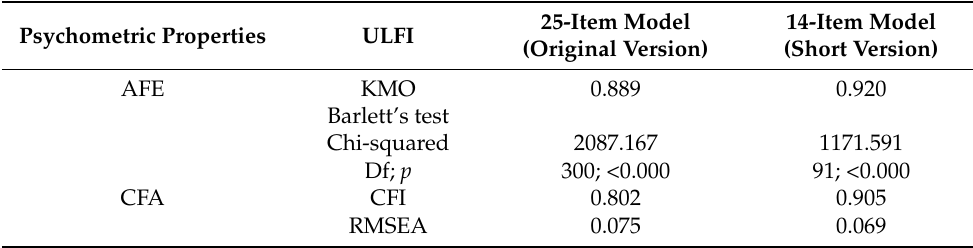
Table 3. Factor structure and factor analysis from ULFI 25-items original version and 14-items short